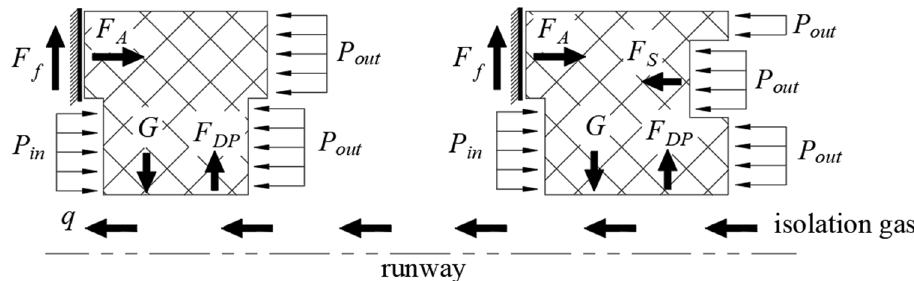
Figure 4. Floating-ring force analysis.